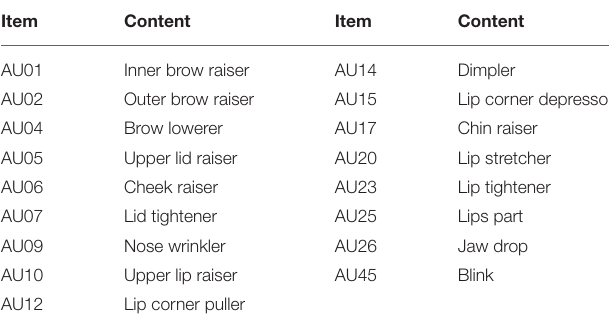
TABLE 1 | The list of action